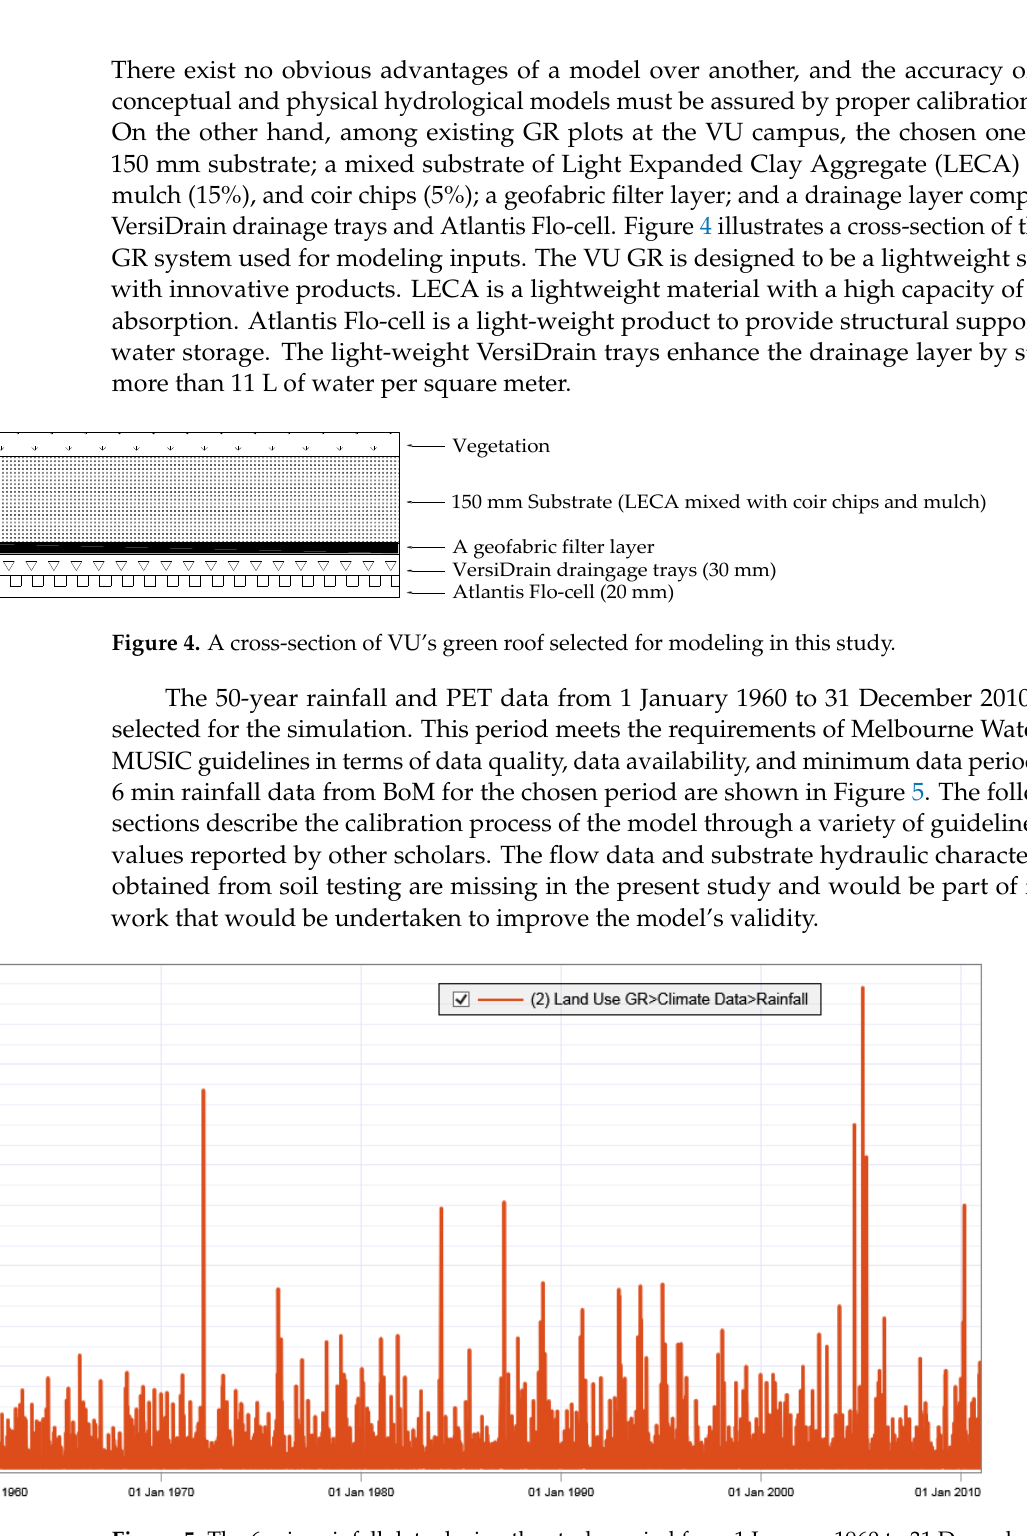
Figure 5. The 6 min rainfall data during the study period from 1 January 1960 to 31 December 2010.